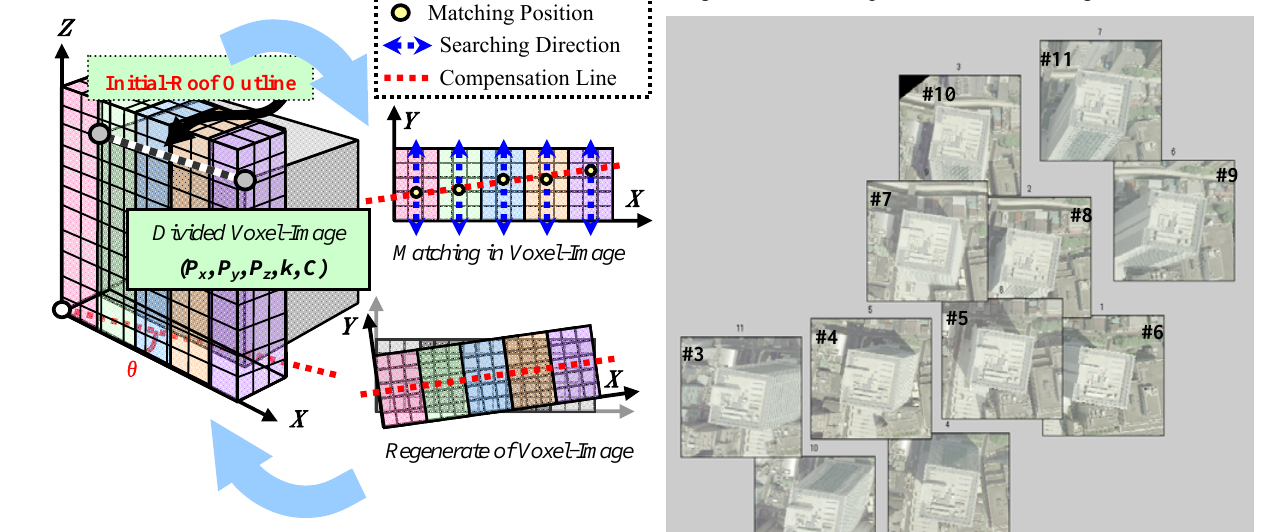
Figure 4. Compensation of Wall